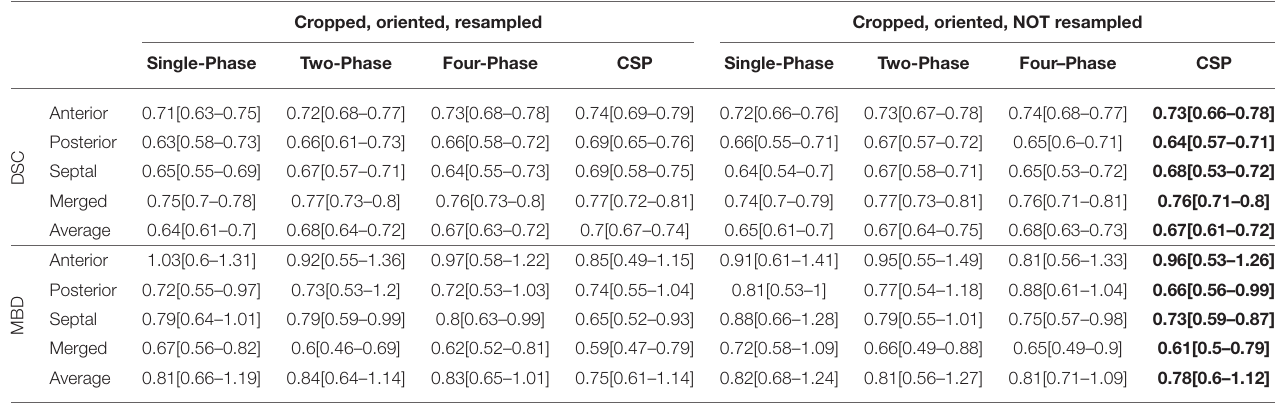
TABLE 1 | Inference Results with Input Image(s) Only across all stages of repair. Cropped, oriented, resampled Cropped, oriented, NOT resampled Single-Phase Two-Phase